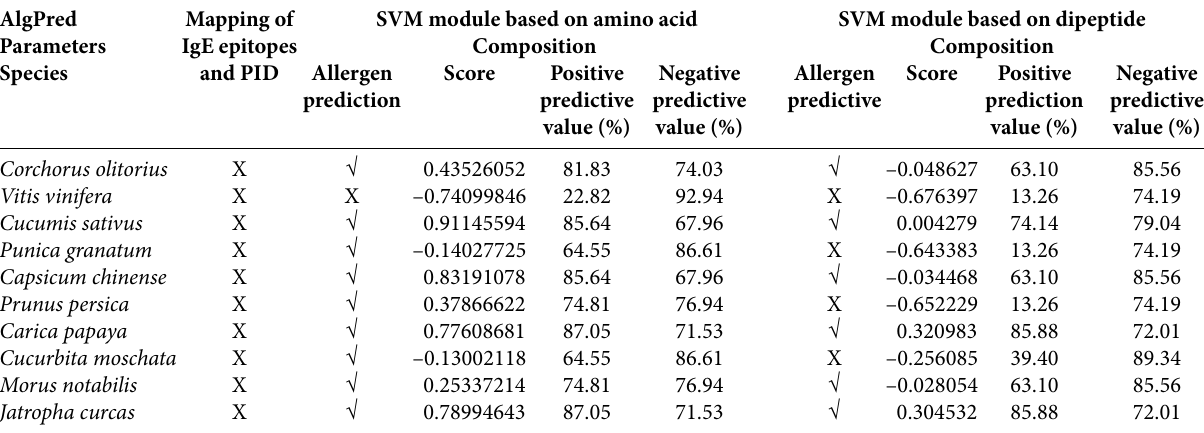
Table 5: AlgPred analysis of diffirent allergens in fruits (The name of the proteins in these species were given in Table 2). AlgPred Mapping of SVM module based on amino acid SVM module based on dipeptide Parameters IgE epitopes